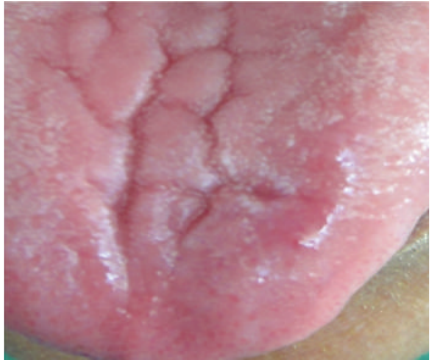
Figure 7: 1 month postoperative photograph.